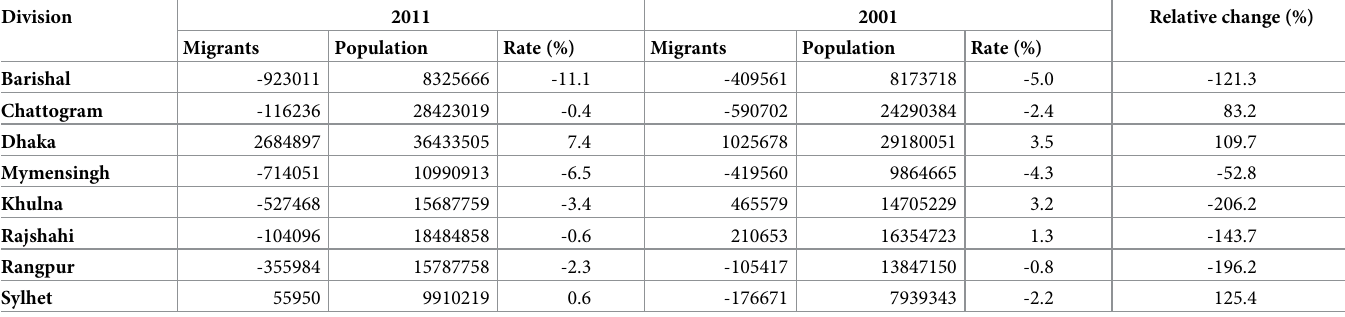
Table 2. Total migrants, population, migration rate (%), and relative change (%) by division.